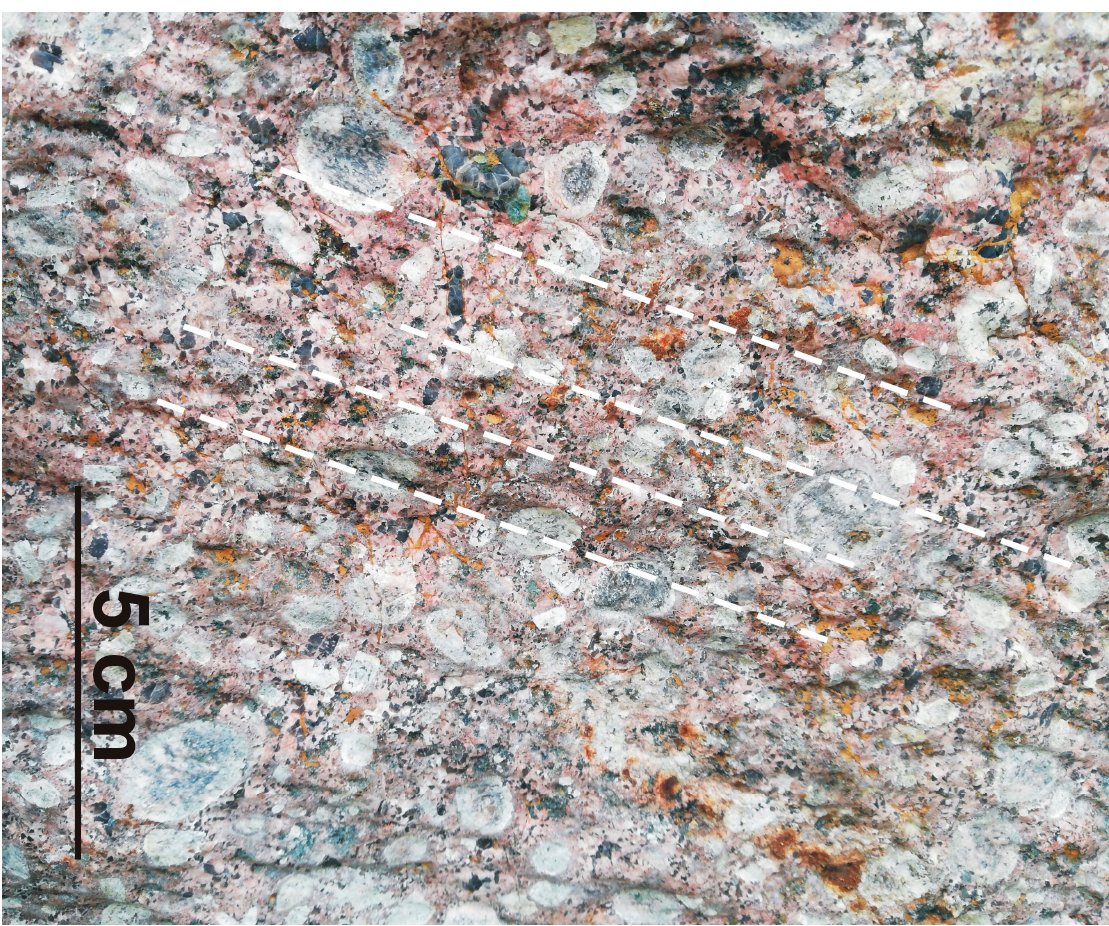
Figure 12. Details of the mineral composition of Åland rapakivi granite (No. 16) with legible aeolian micro-ribs (white hyphens) that developed in a periglacial